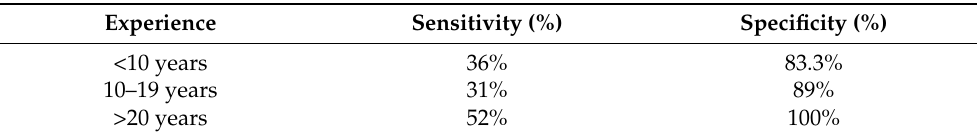
Table 2. The expertise of sonographers and their diagnostic performance in diagnosing appendicitis.